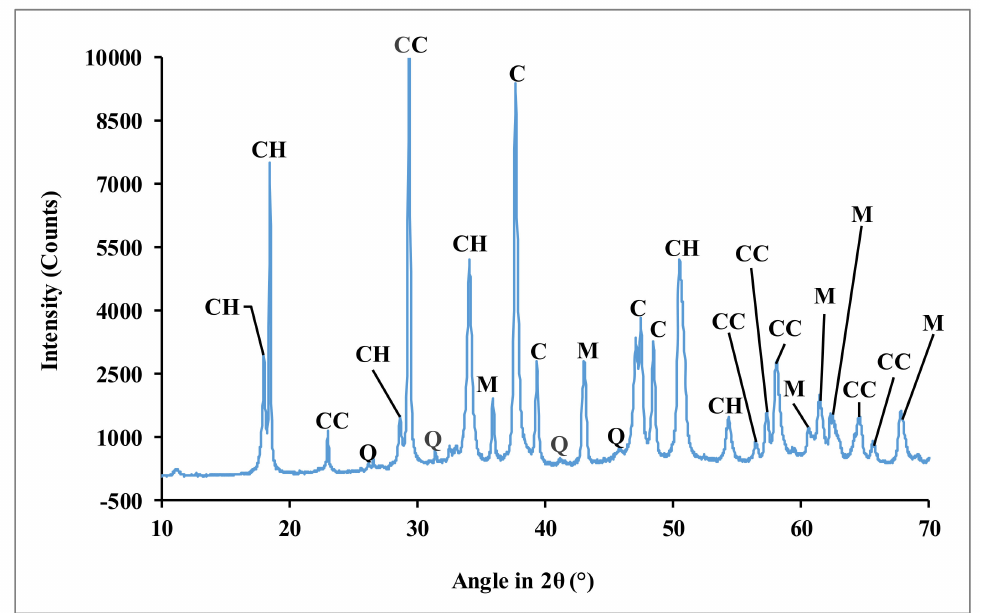
Figure 1. X-ray diffraction pattern of the dolomitic lime (CH: portlandite; C: calcium oxide; CC: calcite; M: magnesium carbonate; and Q: quartz).